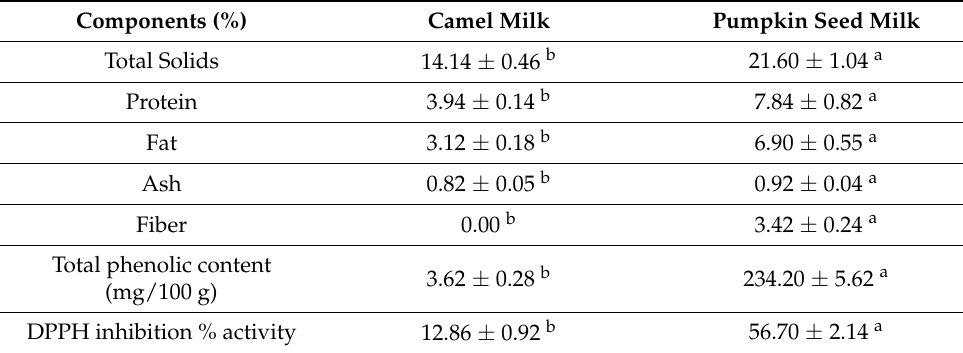
Table 1. Chemical composition of fresh camel milk and pumpkin seed